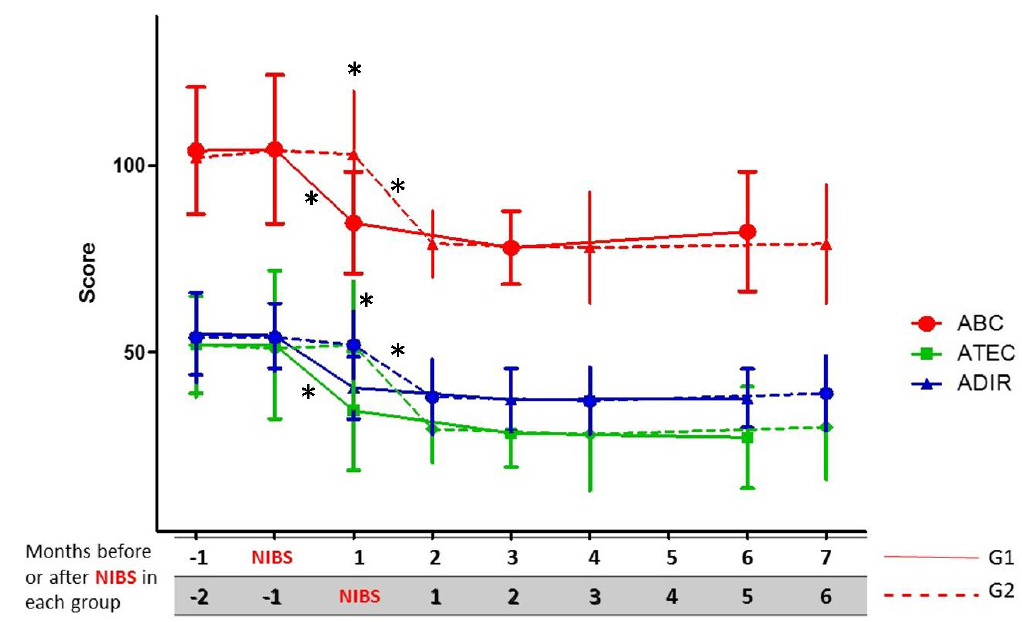
Figure 2. Short-term outcome based on clinical scale scores until six months of follow-up after NIBS in group 1 (G1) and group 2 (G2). * p < 0.05 (significant differences; comparisons between and within each group with scale scores before and after NIBS).